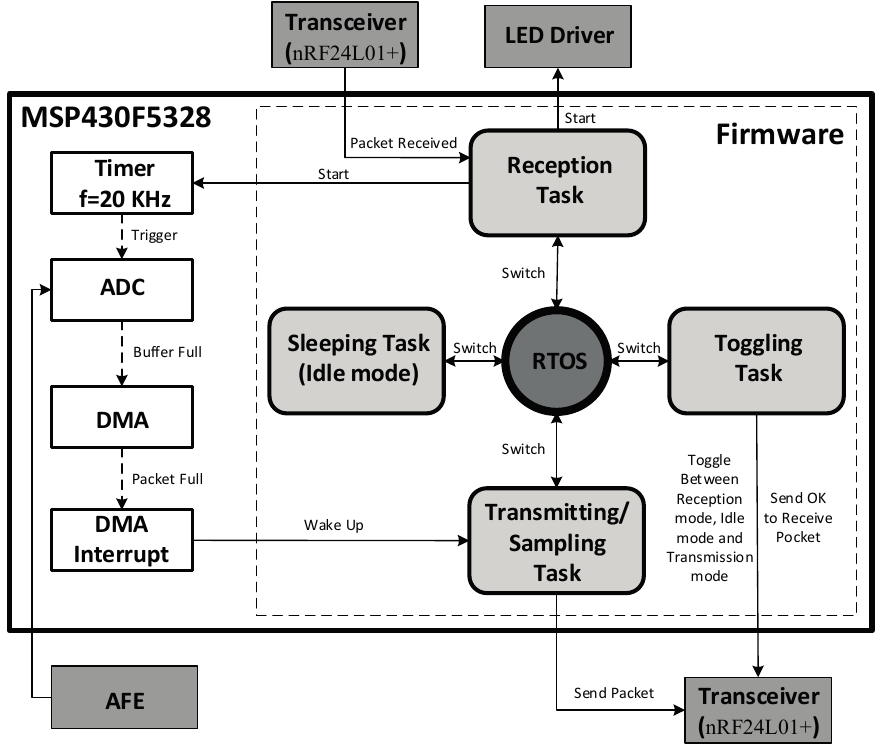
Figure 5. Functional diagram of the control